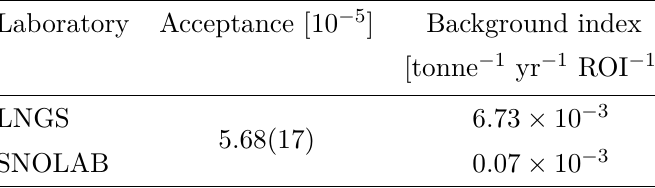
Table 3 . Acceptance factor for the 137 Xe background and resultant contribution to the background index of NEXT-1t for the two example